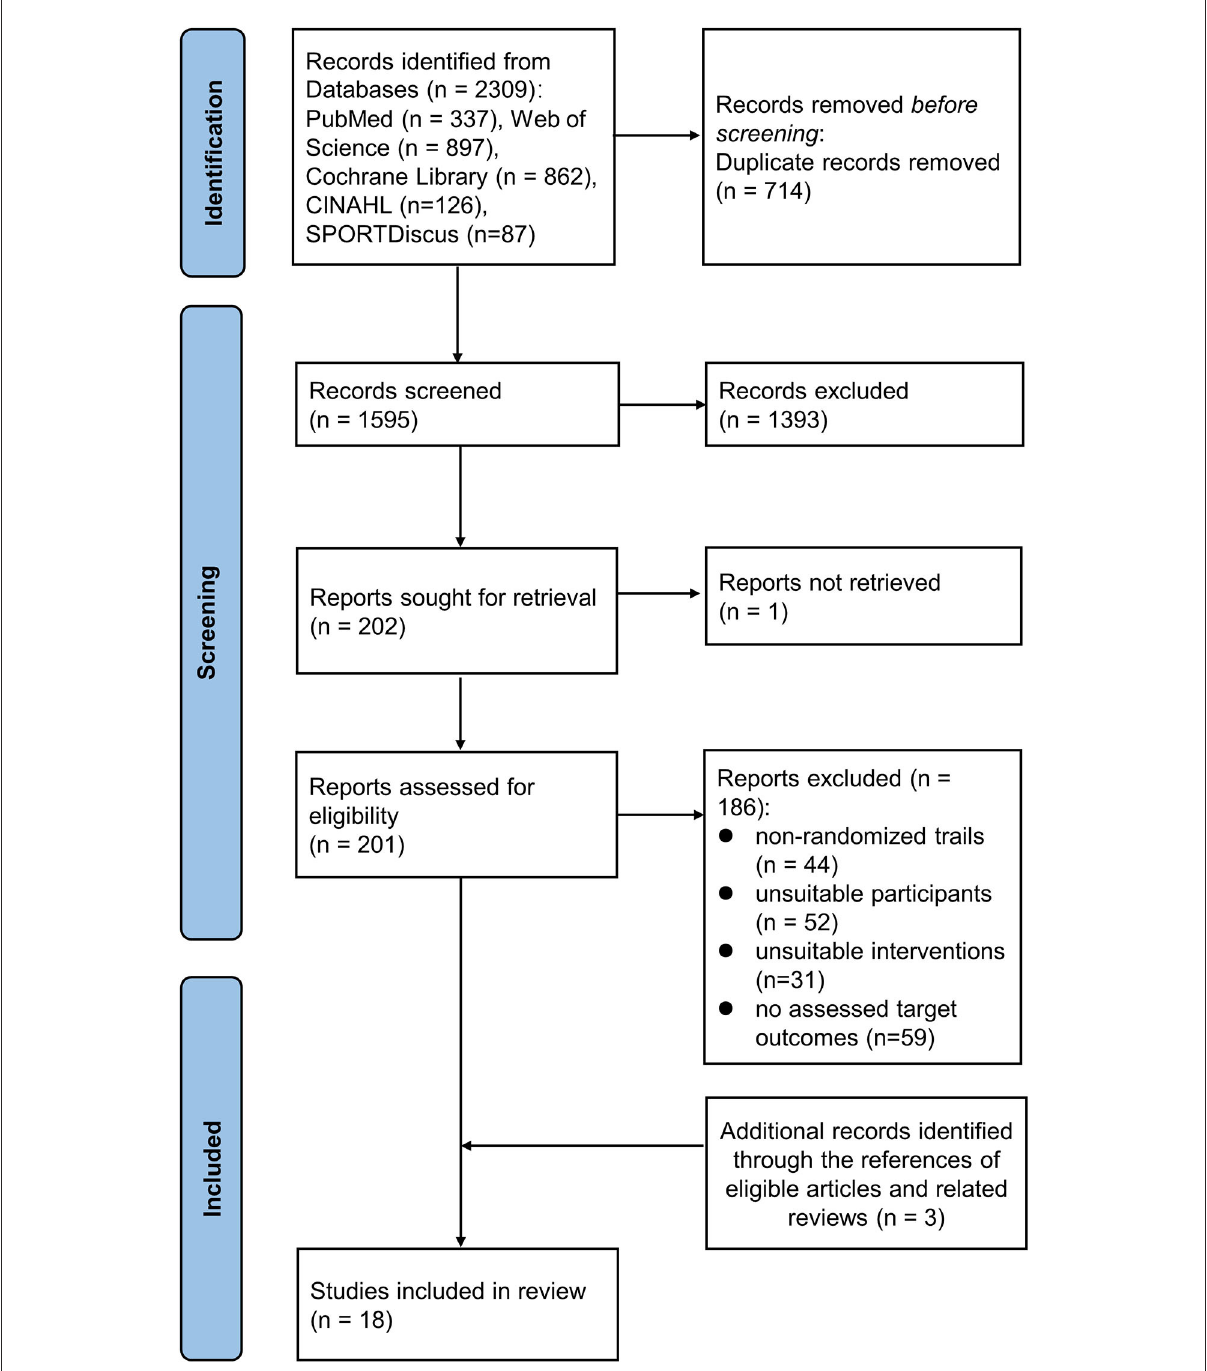
FIGURE1 Flowchart of study selection process through the review.